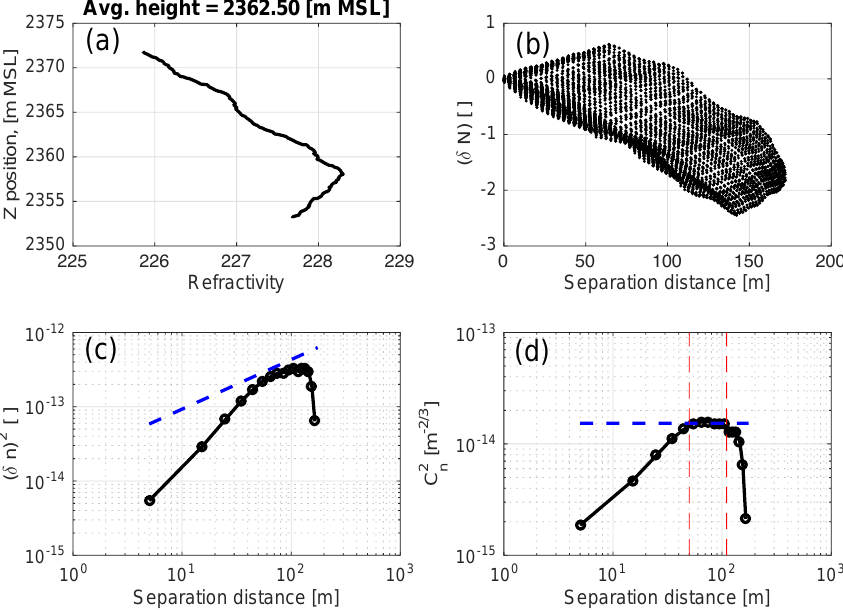
Figure 9. Procedure followed for the evaluation of C 2 n in the inertial subrange (ISR) for the portion of the ascent trajectory similar to the one presented in Fig. 8. (a) Refractivity as a function of height that corresponds to an average height of 2362.50m with a span of 18.75m. (b) Variations for δN with separation distance. Data clearly present a bias due to the helical (non-flat) trajectory. (c) Variations of (δn) 2 with separation evaluated with 10m bin. (d) Variation of C 2 n with distance. The red lines mark the bounds of the ISR, where the turbulence is constant and independent of δ E , and the blue line is the corresponding C 2 n